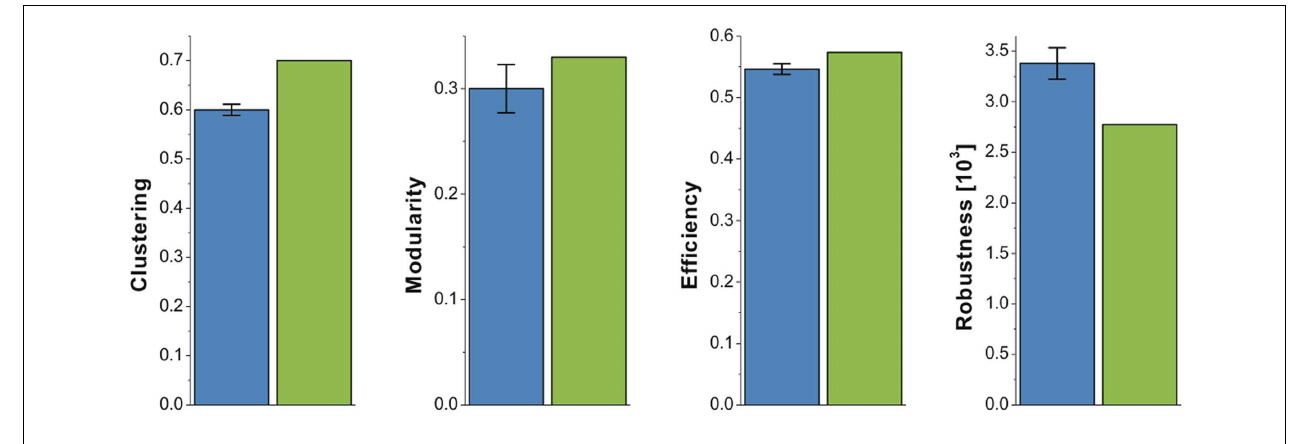
(green), fall outside the 95% confidence interval for these network measures in brain functional networks from 18 healthy volunteers